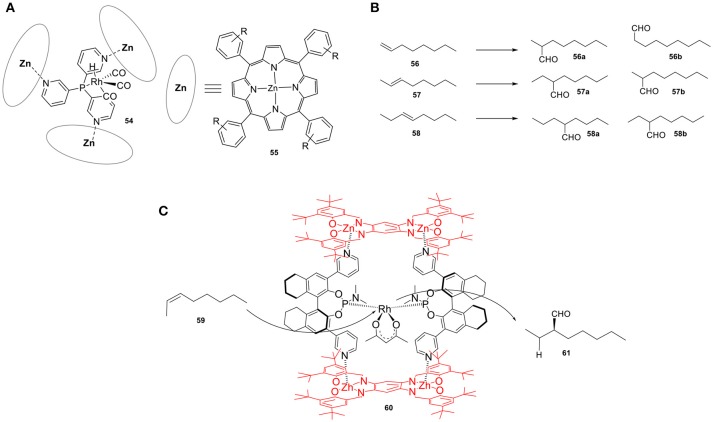
(A) Confined Rh catalyst by three zinc(II)-porphyrin building units (42). (B) Products obtained in alkene hydroformylation. (C) A supramolecular chiral rhodium catalyst employed in the asymmetric hydroformylation of internal alkenes.